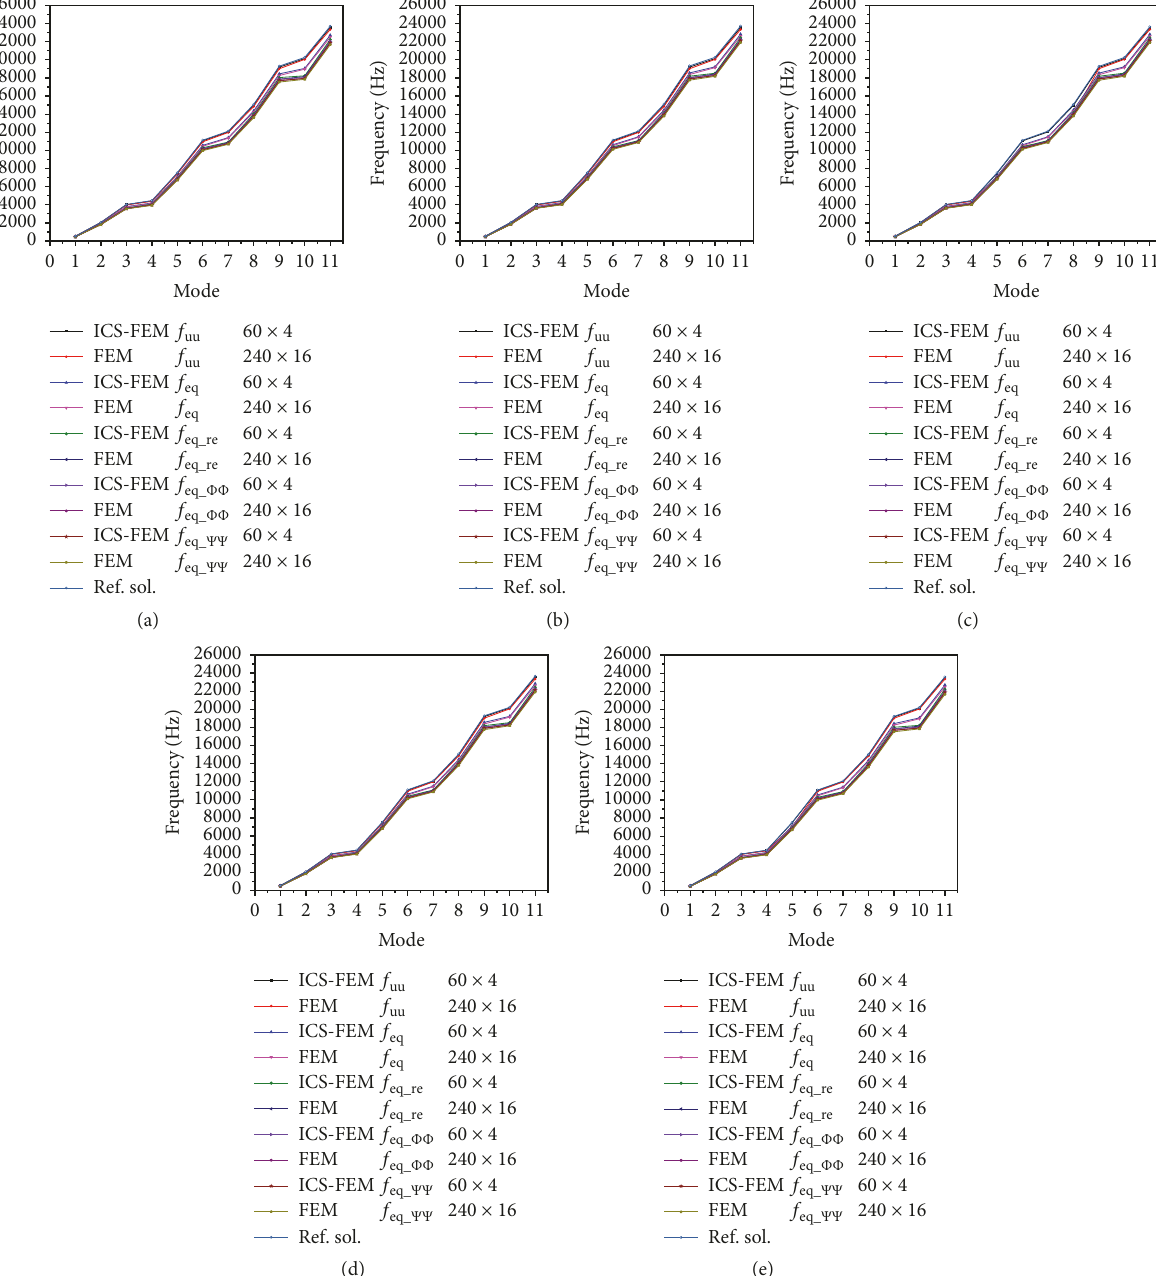
Figure 12: Structural frequencies 𝑓 of simply supported BaTiO 3 -CoFe 2 O 4 FGMEE beams with power law index 𝑛 = (a) 0, (b) 1.0, (c) 5.0, (d) 10.0, and (e)